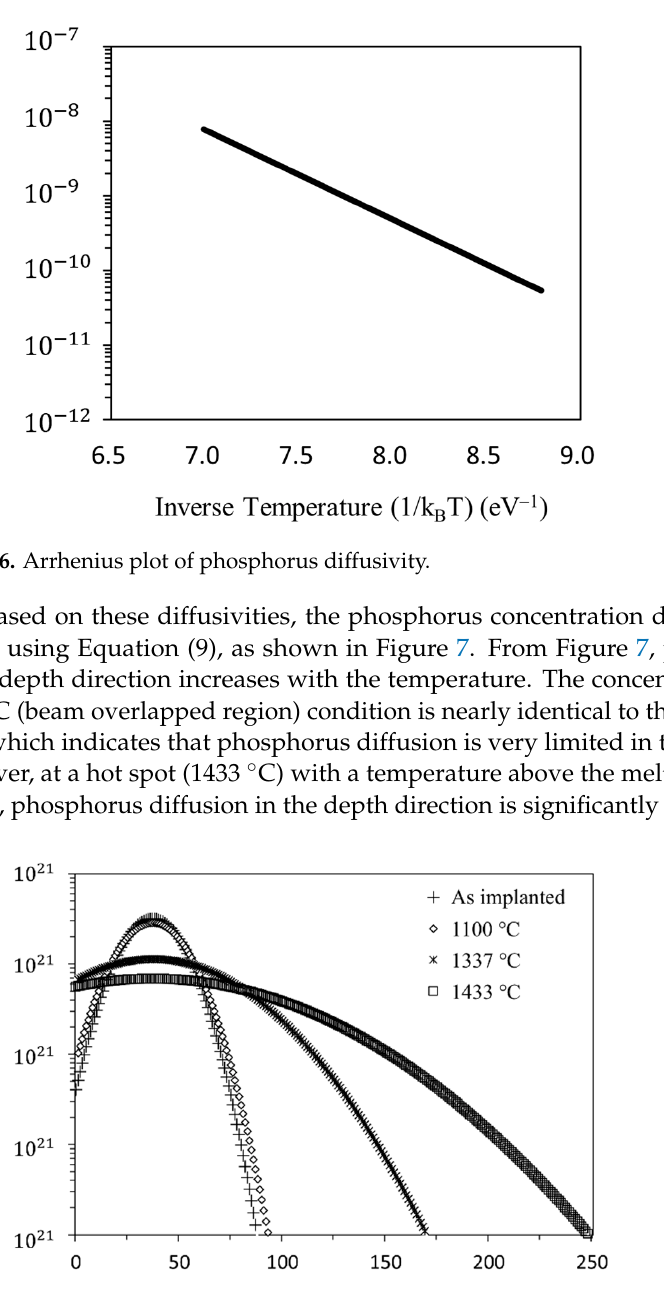
Figure 6. Arrhenius plot of phosphorus diffusivity.